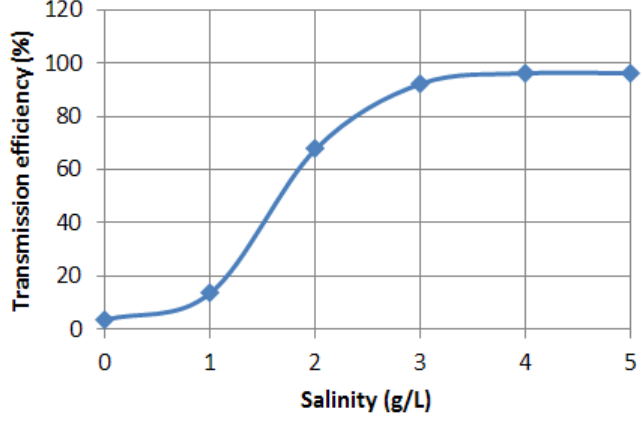
Figure 4. Measured transmission efficiency as a function of salinity.